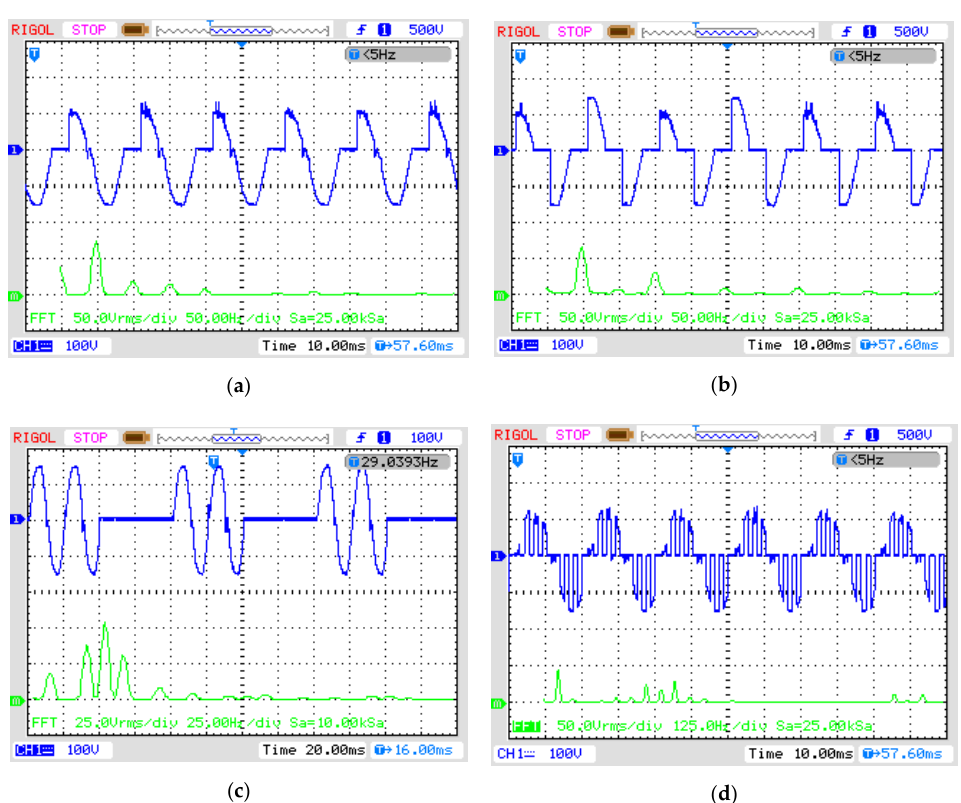
Figure 10. Practical waveform of the output voltage: ( a ) phase-angle with unipolar control; ( b ) phase-angle with bipolar control ( c ) on-off cycle control; ( d ) PWM control. The harmonics in the output voltage with PWM control can be easily suppressed with a low pass filter like other voltage control techniques as the generated harmonics with PWM control can be moved to high frequencies (switching frequencies) by increasing the switching frequencies. Figure 11 shows the output voltage and its FFT if the PWM output is passed through a low pass filter.